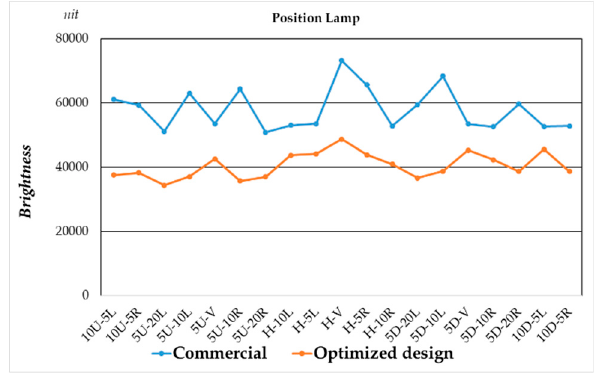
Figure 11. The comparison of the simulated brightness result for the considered angles of EU ECE regulation between the new optimized position lamp and the commercial one.